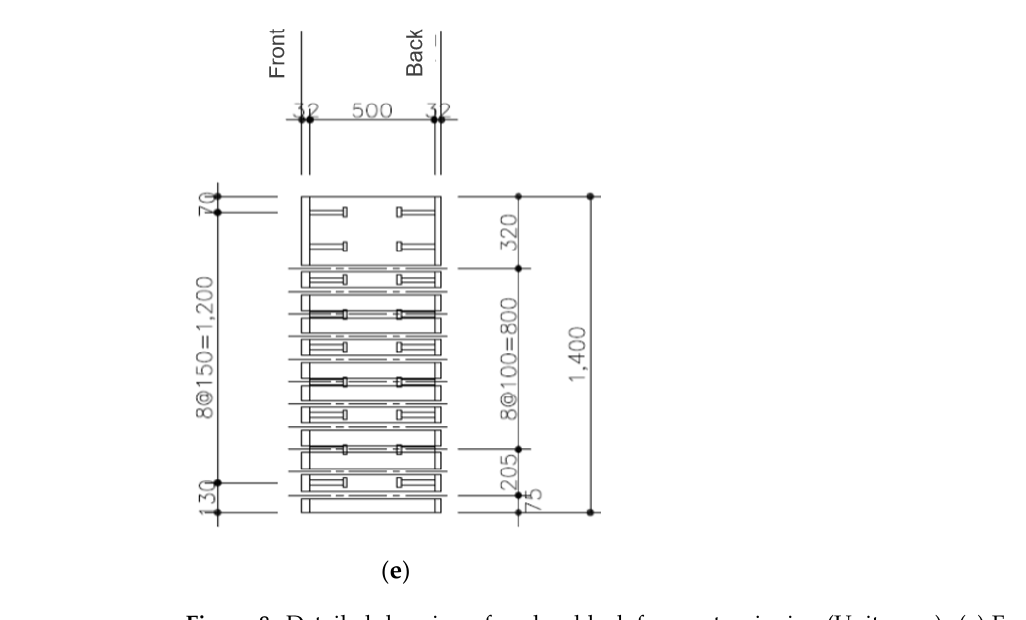
Figure 8. Detailed drawing of anchor block for pre-tensioning (Unit: mm). ( a ) Front view of the anchor blocks. ( b ) Rear view of the anchor blocks. ( c ) Upper plan view of the anchor blocks. ( d ) Lower plan view of the anchor blocks. ( e ) Side view of the anchor blocks.